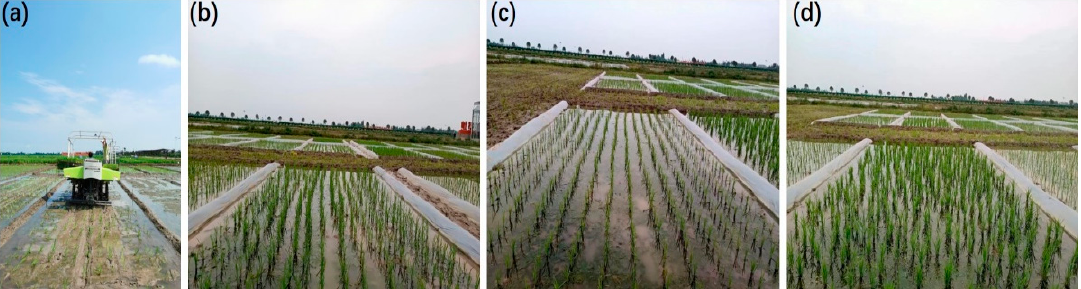
Figure 1. Pictorial illustration of the field performance of orderly mechanical seedling transplanting ( a , b ); manual transplanting ( c ); and manual seedling throwing ( d ).